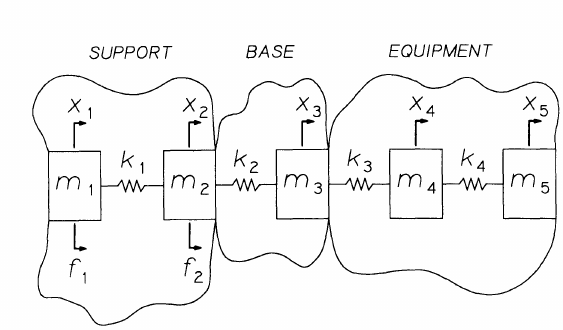
FIGURE 1 5-DOF, free-free, dynamic system, with 0.5% of critical damping